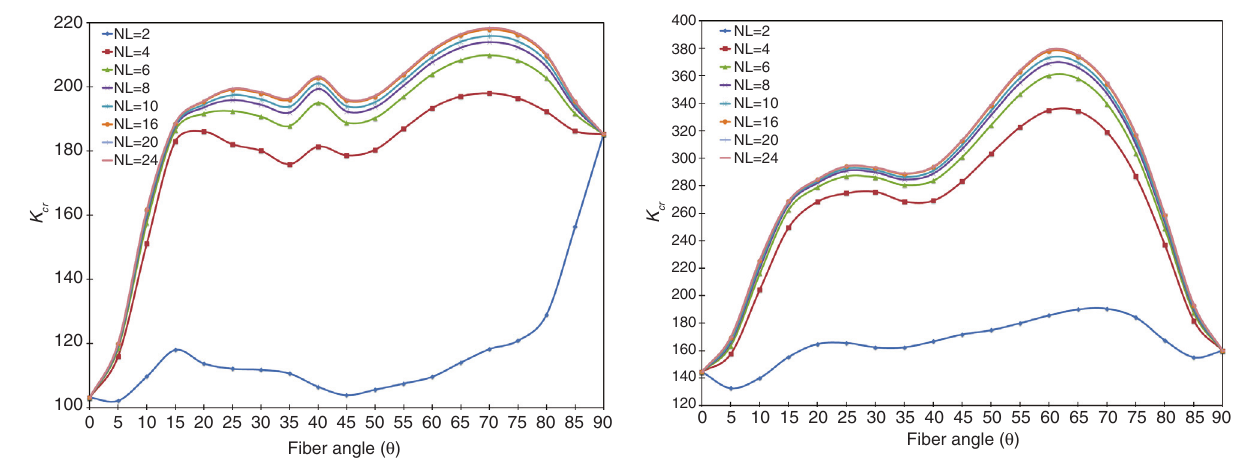
Figure 15 Critical buckling load parameter for clamped antisymmet- ric cylindrical skew panel (Ø = 30 ° , α = 0 ° ).